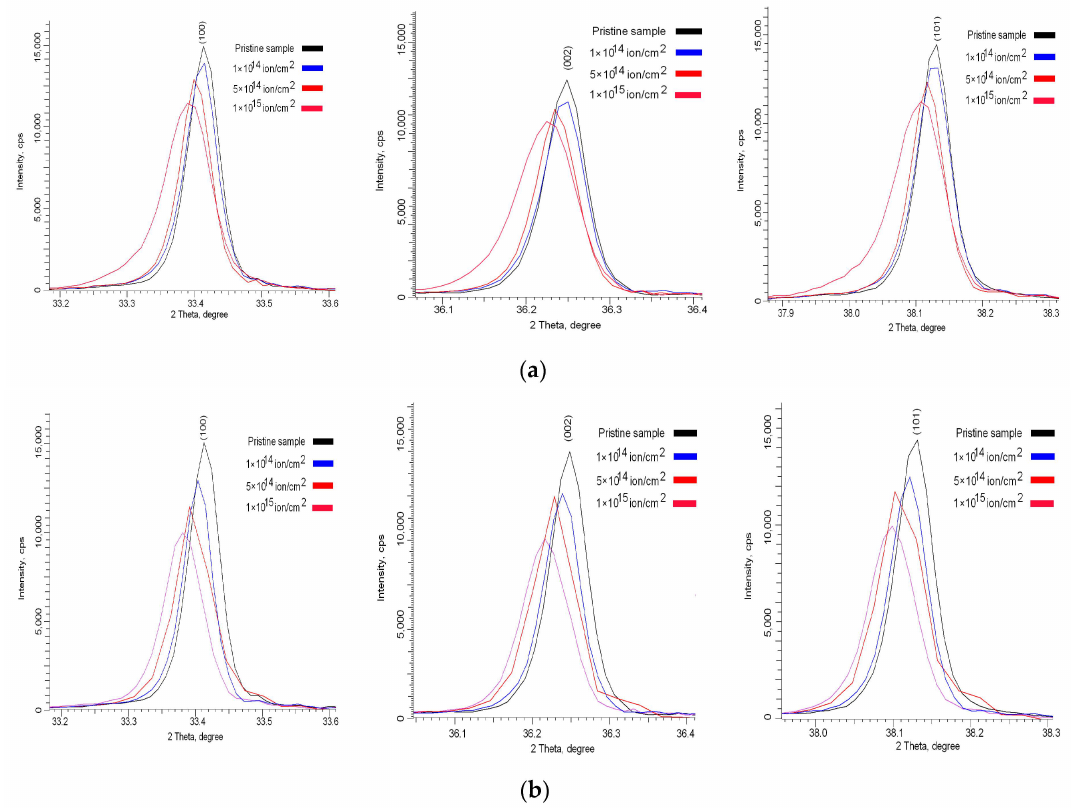
Figure 10. Detailed change of di ff raction maxima (100), (002) and (101): ( a ) Kr 15 + ion irradiated dose; ( b ) Xe 22 + ion irradiated